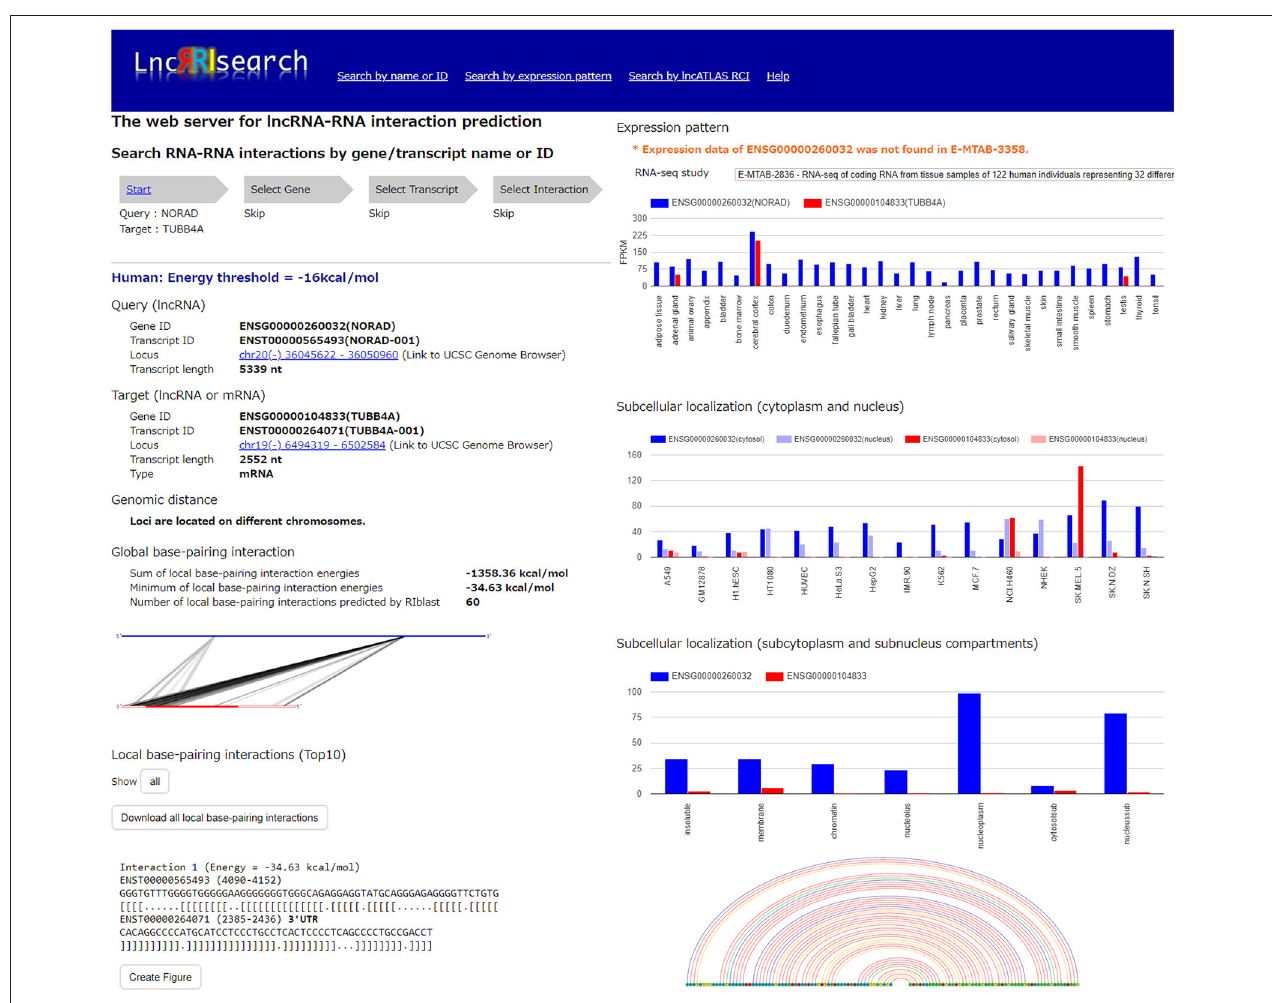
FIGURE 2 | Investigation of lncRNA–RNA interactions using LncRRIsearch. In this example, detailed information about the interaction between NORAD lncRNA (used as query, Gene ID:ENSG00000260032, Transcript ID: ENST00000565493) and TUBB4A mRNA (used as target, Gene ID:ENSG00000104833, Transcript ID:ENST00000264071) is